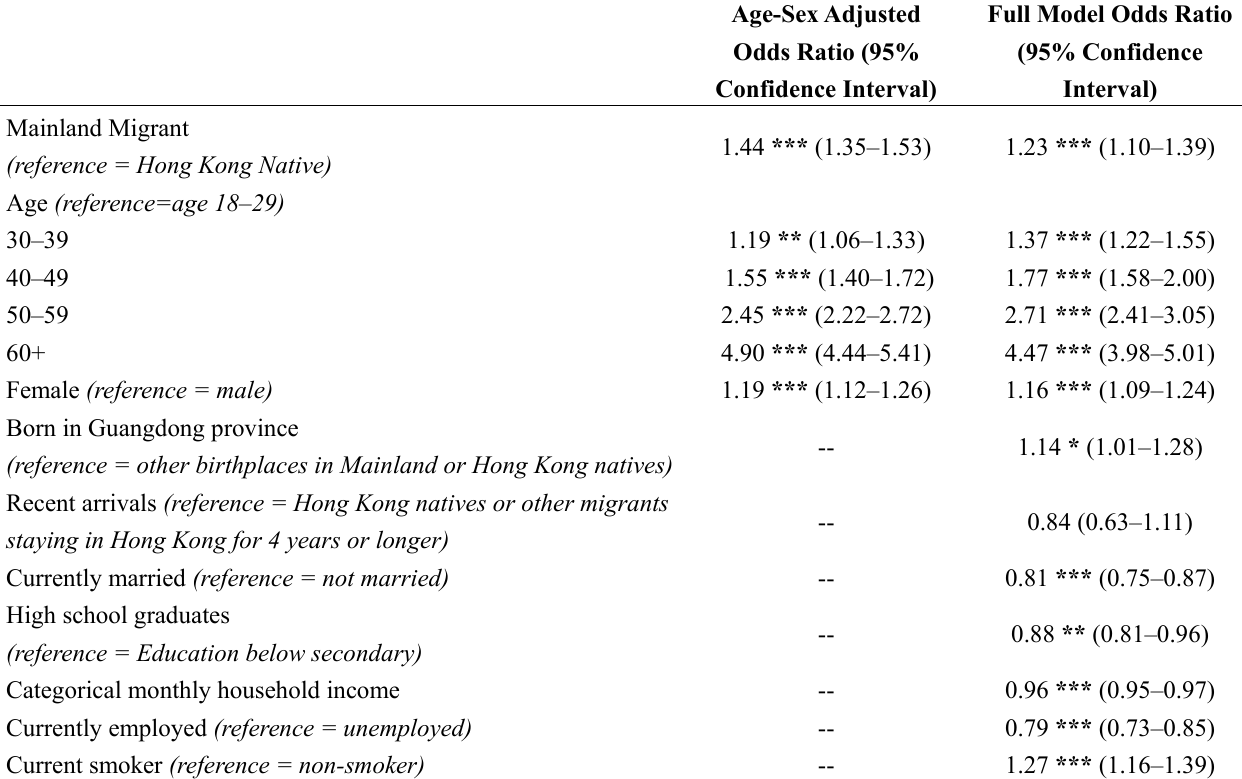
Table 3. Results of the logit regression of self-reported poor health among Hong Kong adult